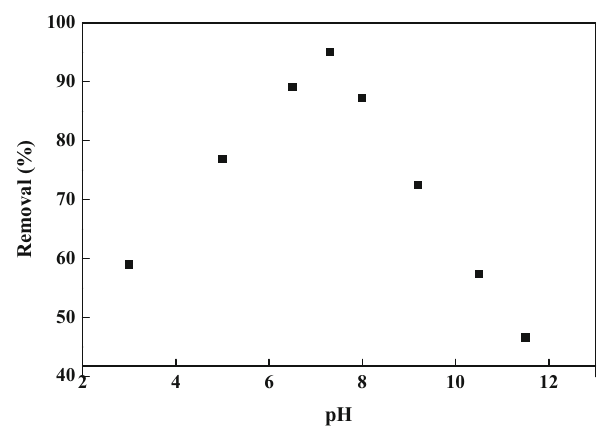
Fig. 6 The Langmuir adsorption isotherms for pre-treated coffee waste at